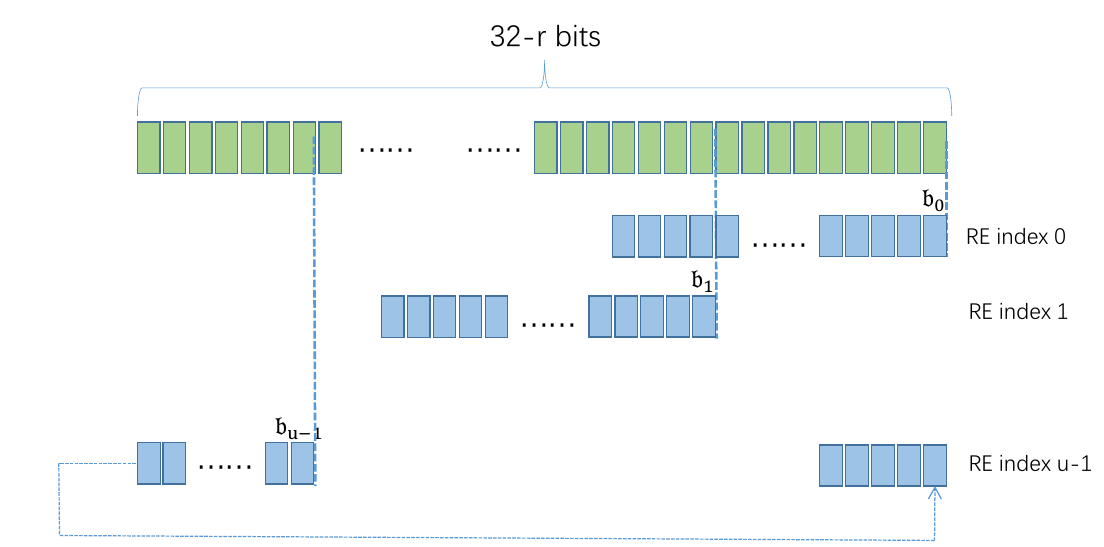
Figure 4. Locate RE by the left part of IP address. RE estimator only determine whether the host is a global candidate super point, but cannot give an estimate of the cardinality. Therefore, READ uses LE to estimate the cardinality of each global candidate super points. READ uses LE array of ˆ u rows and ˆ v columns to record the opposite hosts of a , as shown in Figure 5.